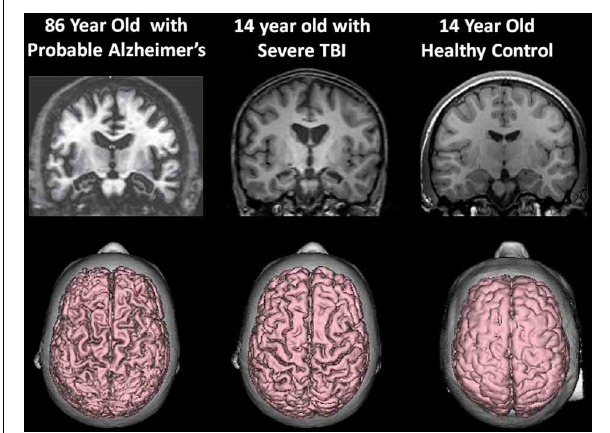
FIGURE 8 | (Top) T1-weighted coronal images approximately at the same level showing hippocampal atrophy in the 86-year-old patient with a clinical diagnosis of Alzheimer’s disease and the 14-year-old patient with severe traumatic brain injury (TBI). Note compared to the control coronal image on the right, both the TBI case and the Alzheimer’s exhibit hippocampal atrophy, ventricular dilation and sulcal widening. (Bottom) All images are 3-D renderings from volume acquisition magnetic resonance imaging (MRI) depicting the dorsal view of the brain in each subject described above. Note the similarity of the diffuse pattern of atrophic change that has occurred in both the patient with Alzheimer’s disease and the adolescent who survived severe TBI. Clearly, the elderly patient with Alzheimer’s has more severe atrophy but nonetheless the atrophy in the TBI adolescent is substantial, especially when compared to the typical developing adolescent control. Note: The patient with Alzheimer’s disease is taken from Jacobson et al. (2009); this patient’s clinical findings, including additional neuroimaging and neuropsychological details are described in that publication. Reproduced with permission from John Wiley and